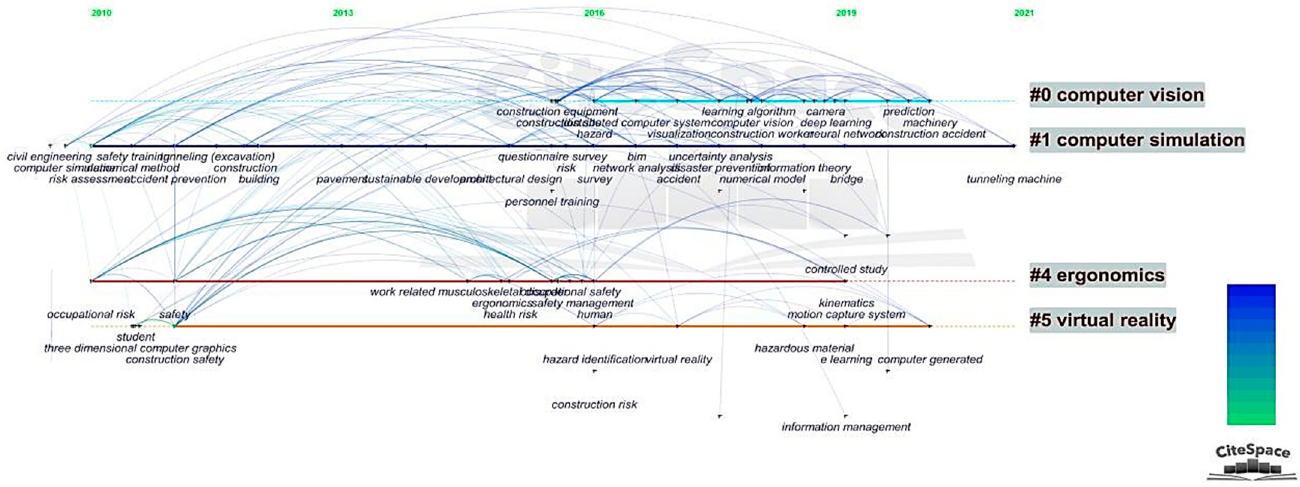
Figure 8. Timeline analysis.